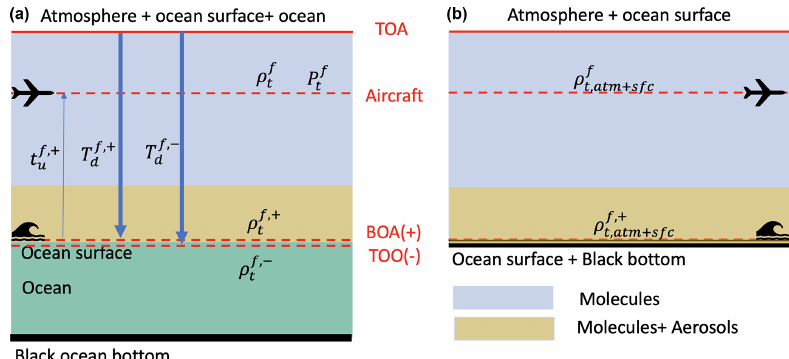
Figure 1. Panel (a) shows the coupled atmosphere and ocean system used in FastMAPOL including the atmosphere, ocean surface, and ocean body. Panel (b) represents a system used for atmospheric correction which only has atmosphere and ocean surface without scattering in the ocean body. The atmospheres in both systems are modeled as the same three layers. TOA indicates the top of the atmosphere. The bottom of the atmosphere (BOA) and the top of the ocean (TOO) indicate the locations just above and below the ocean surface, respectively. All quantities shown in the figures need to be computed from the forward model and represented by the NN for efficient calculations. Symbols are defined in Table